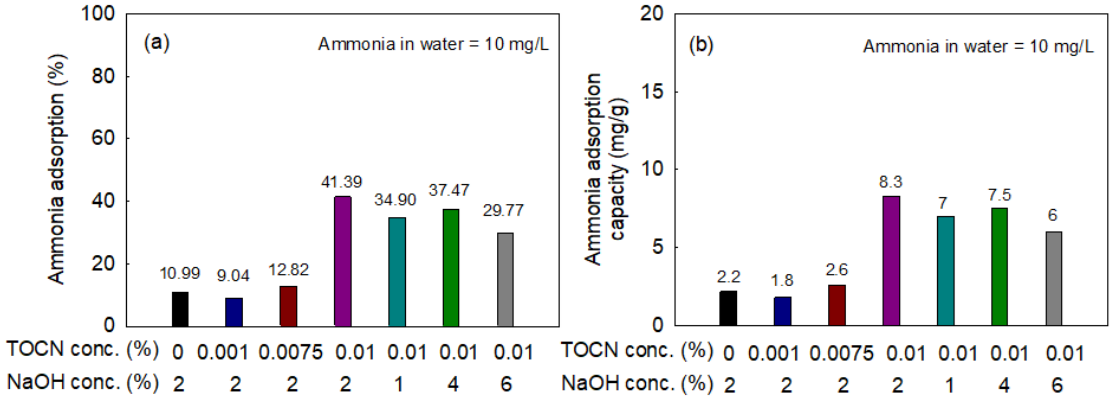
Figure 8. Ammonia adsorption percentage ( a ) and ammonia adsorption capacity ( b ) for various TOCN and NaOH concentrations.